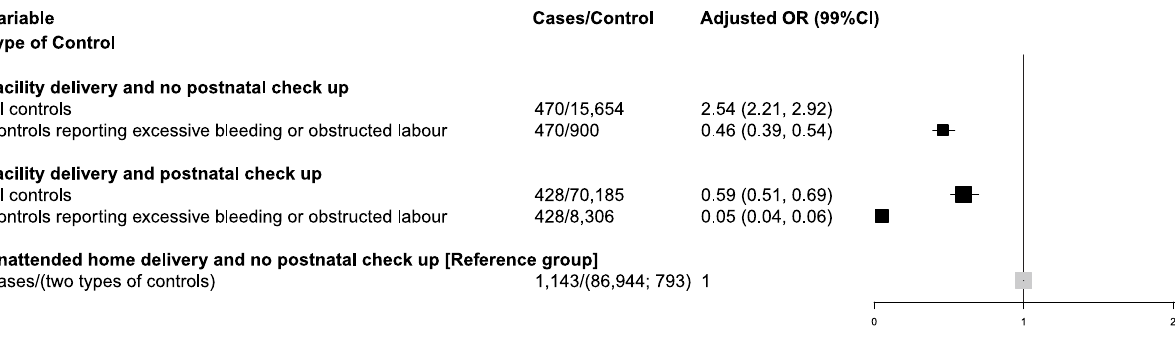
Fig 1. Adjusted odds ratios for neonatal death for facility deliveries by different controls, India 2004 – 08.